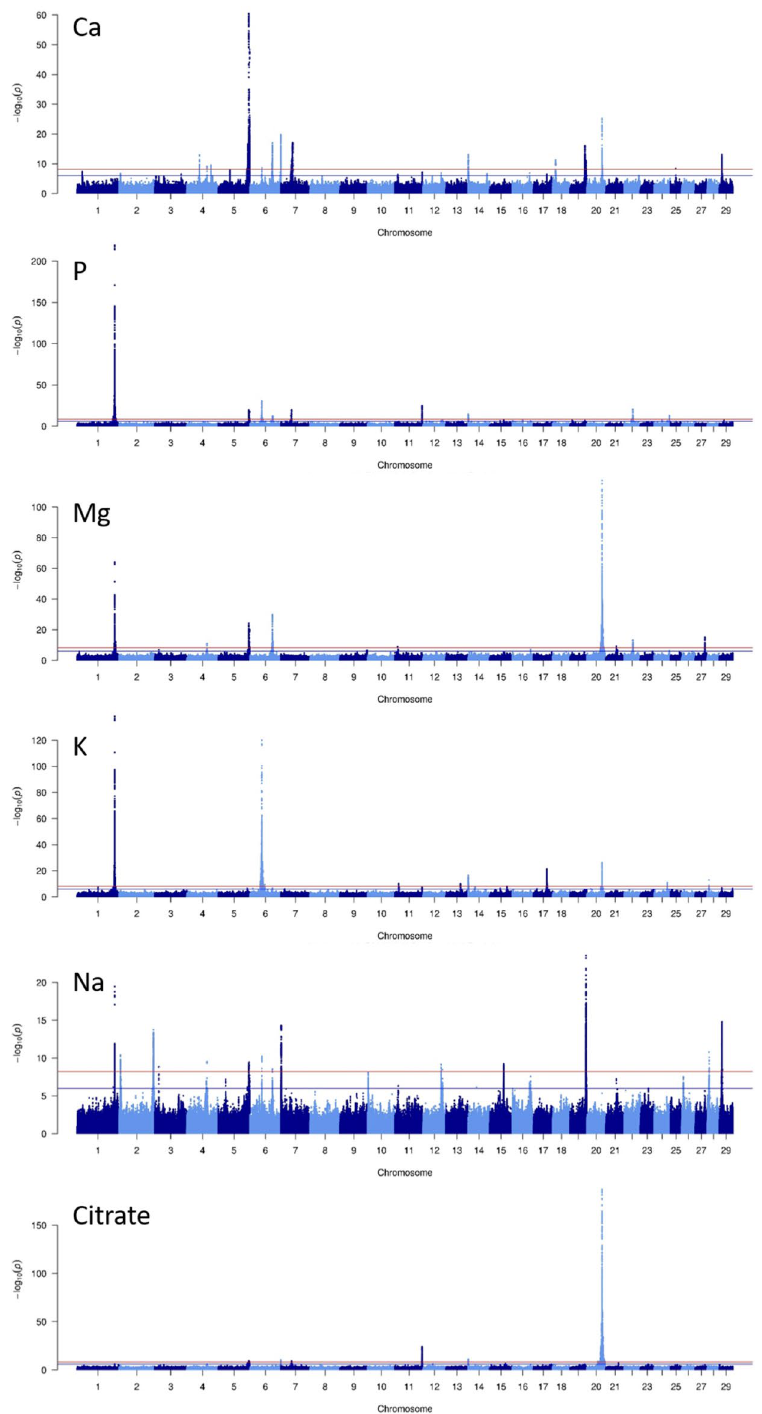
Figure 1. –log 10 ( P ) value of the effect of variants on milk mineral (Ca, P, Mg, K, and Na) or citrate content plotted against their position on Bos taurus